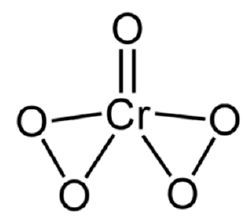
Figure 9. The molecular structure of chromium(VI)